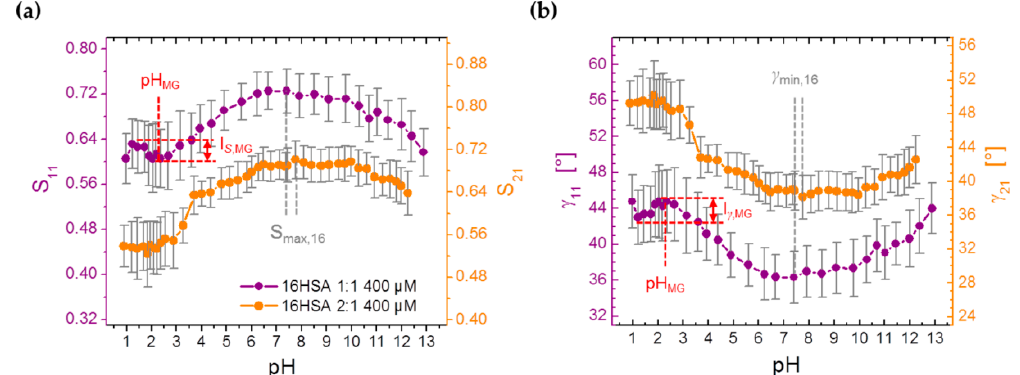
Figure 7. pH ‐ dependence of order parameters S and wobbling angles γ from 16 ‐ DSA ‐ probed HSA. The order parameters and wobbling angles from CW EPR spectra in Figure 3b–c are plotted in the observed pH range for both loading ratios (1:1 (purple) and 2:1 (orange)). MG ‐ related features are highlighted with red dotted lines. All calculated error bars are given in gray. ( a ) The order parameters S 11 and S 21 of 16 ‐ DSA interacting with HSA as a function of pH. The global maximum value for both curves is given with gray dotted lines ( S max,16 ). The order parameter depletion I S ,MG around pH 2 is correlated with an MG ‐ like state. ( b ) Wobbling angles γ 11 and γ 21 of 16 ‐ DSA interacting with HSA are shown as a function of pH. The global minimum value for both curves is given with gray dotted lines ( γ min,16 ). The increase of the wobbling amplitude I γ ,MG around pH 2 is here correlated with the emergence of a MG ‐ like state.